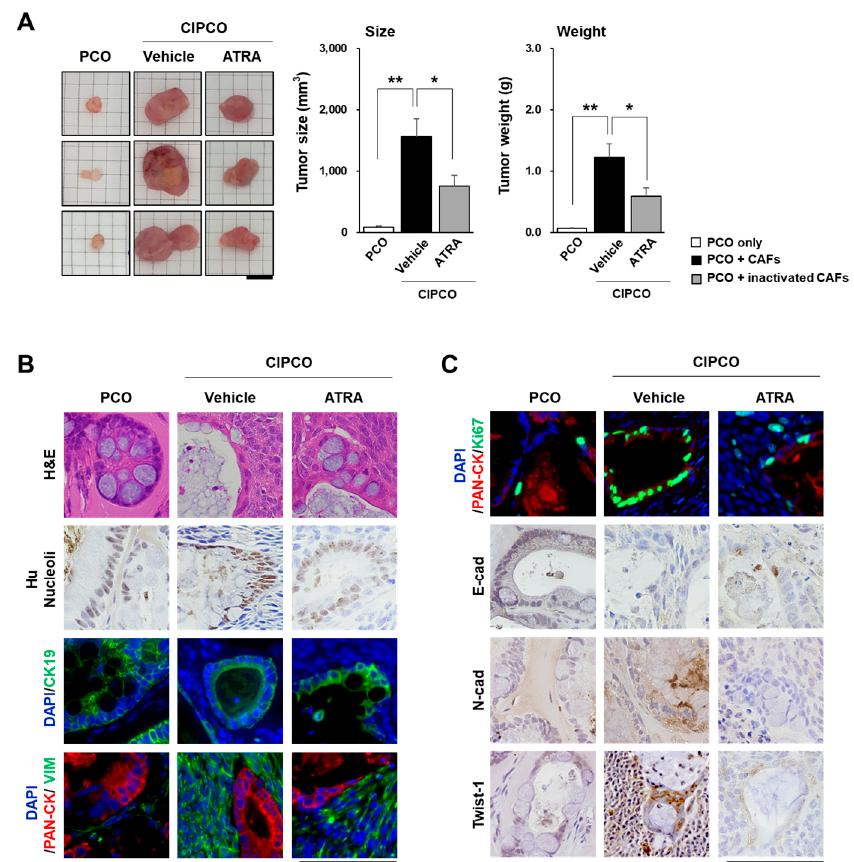
Figure 3. Characteristics of the tumors in xenograft models of PCOs, CIPCOs, and ATRA CIPCOs. ( A ) Comparison of tumor size and weight between the three groups. ( n = 5) * p < 0.05, ** p < 0.01. Bar = 1 cm. ( B , C ) Immunofluorescence/immunohistochemical analysis of PCO, CIPCO, and ATRA CIPCO xenograft tumors. Bar = 100 µm.